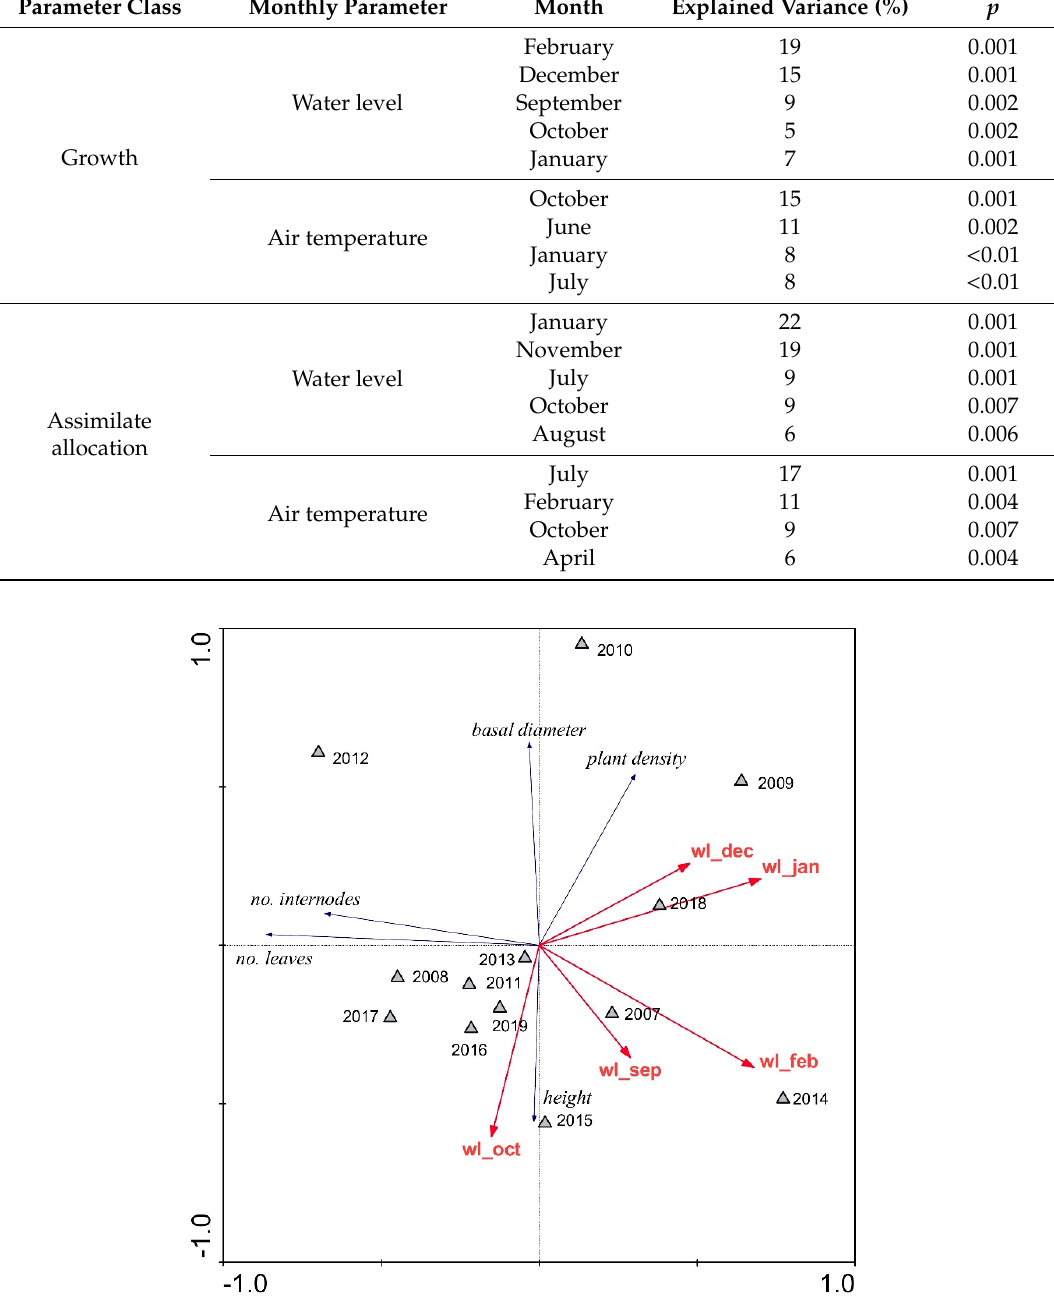
Table 5. Redundancy analysis for the significant explained variance for the growth and assimilate allocation parameters for the riparian reed stand (Gorenje Jezero), as defined by the monthly water levels and air temperatures.